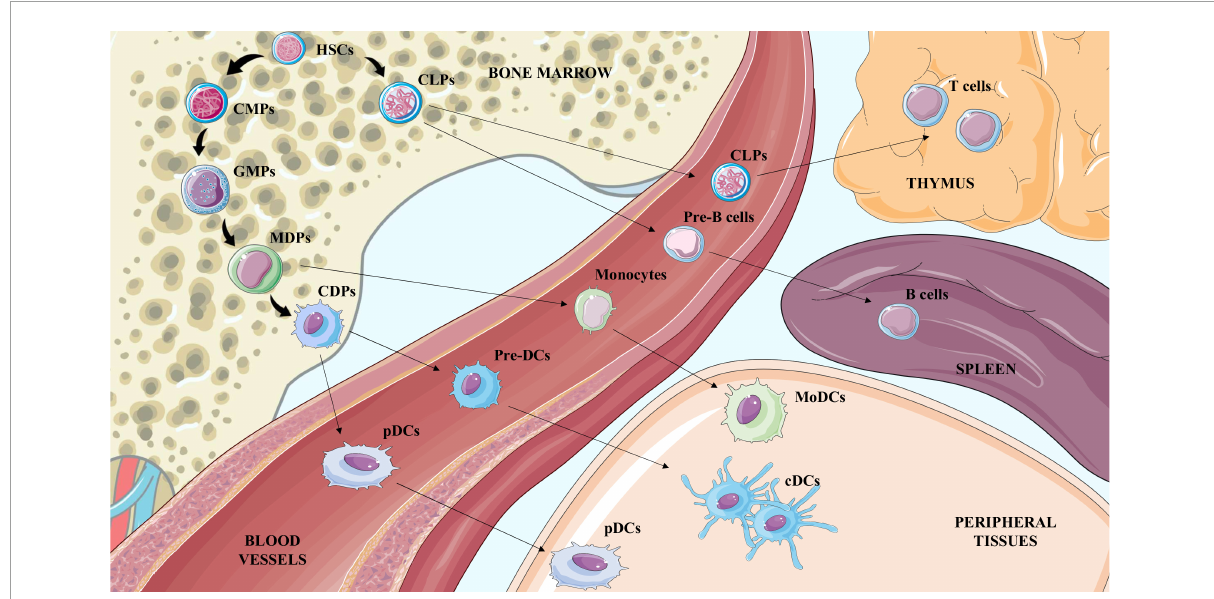
FIGURE1 Illustration of hematopoietic stem cells (HSCs) differentiation to terminal blood and tissue cells. Hematopoietic stem cells (HSCs) generate common lymphoid progenitors (CLPs) and common myeloid progenitors (CMPs). CLPs exit the bone marrow to reach the thymus or the spleen and generate lymphocyte T and lymphocyte B cells respectively. CMPs differentiate to Granulocyte-Macrophage Progenitors (GMPs) which are the precursors of monocyte-DC progenitors (MDPs), and common DC progenitors (CDPs). CDPs mature to preDCs and pDCs in the bloodstream; once in the tissue preDCs differentiate in conventional DCs (cDCs). MDPs mature to monocytes in the blood and once in peripheral tissues give rise to macrophages and also to MoDCs.